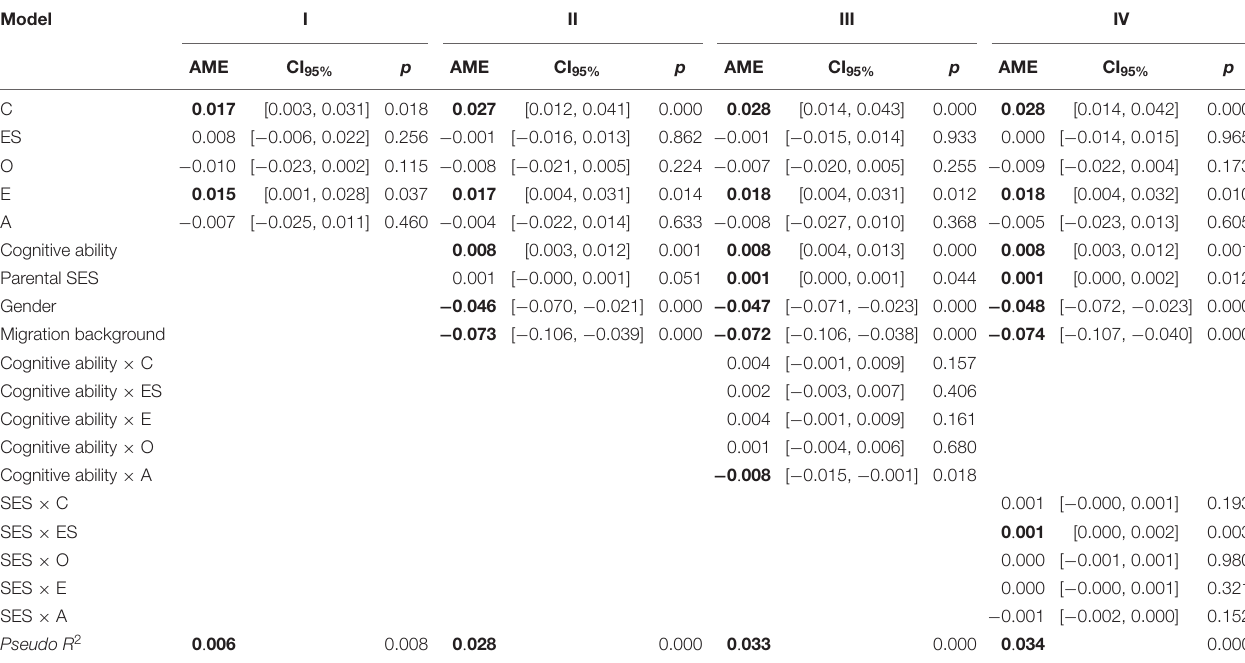
TABLE 3 | Average marginal effects for obtaining a VET position within 1 year after graduation (given the submission of an application) regressed on the Big Five and the covariates. Model